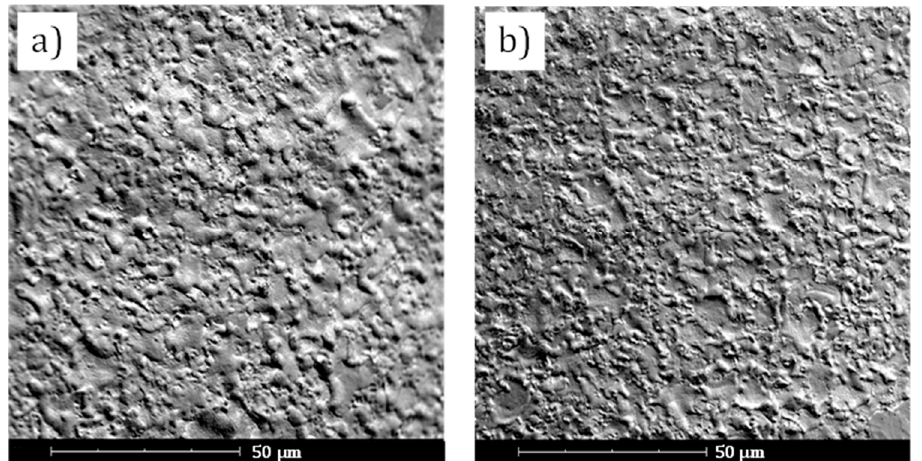
Figure 7. Surface morphology of a microrod ( a ) before and ( b ) after the finishing step. The images are taken by means of Phenom ® Pro scanning electron microscope.